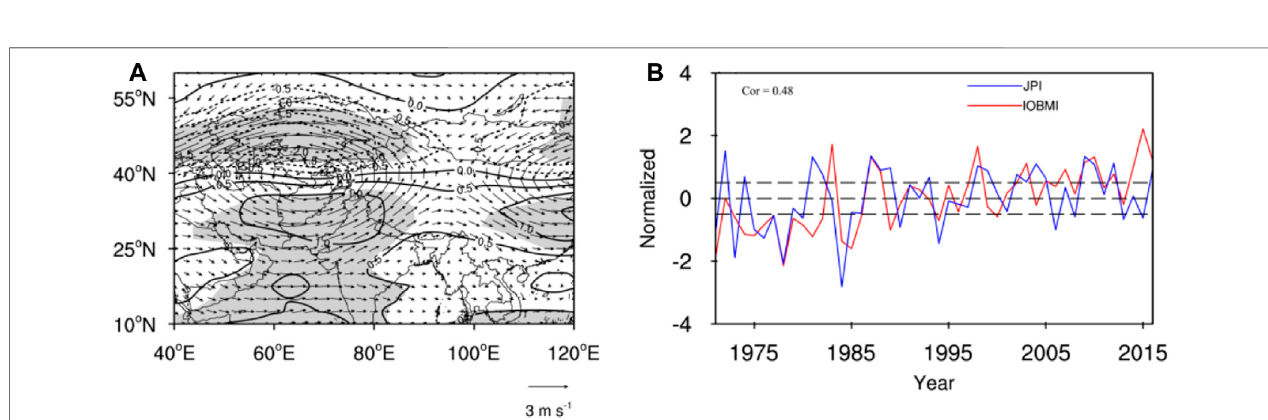
FIGURE 7 | (A) Regression of 200-hPa zonal wind (contours) and winds (vectors) against the IOBMI during 1971 – 2016; Shaded regions show signi fi cance at α (cid:2) 0 . 05 level. (B) Time series of the IOBMI and JPI during 1971 – 2016.